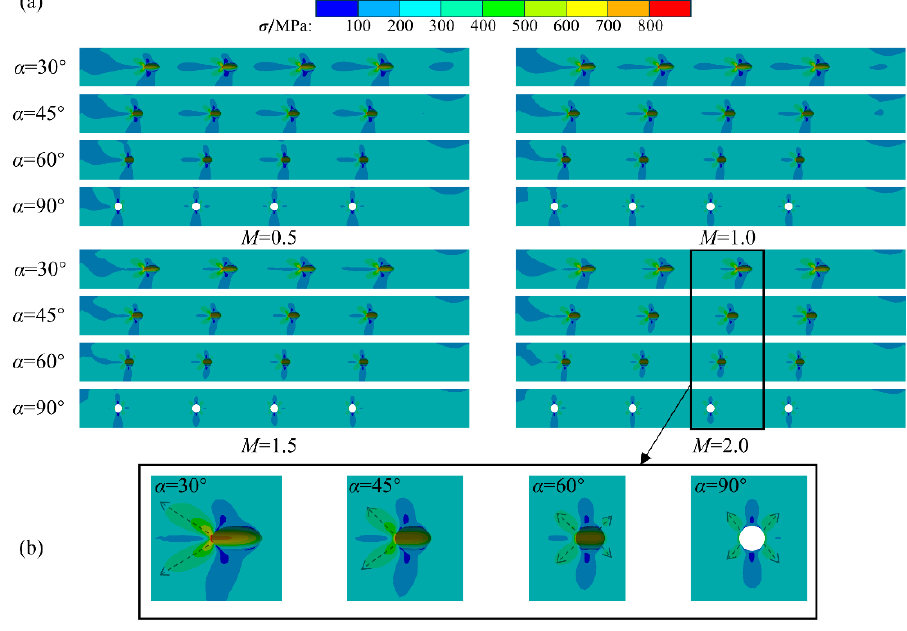
Figure 21. Contours of thermomechanical stress: ( a ) on the internal wall of film plate; ( b ) near the research film hole.